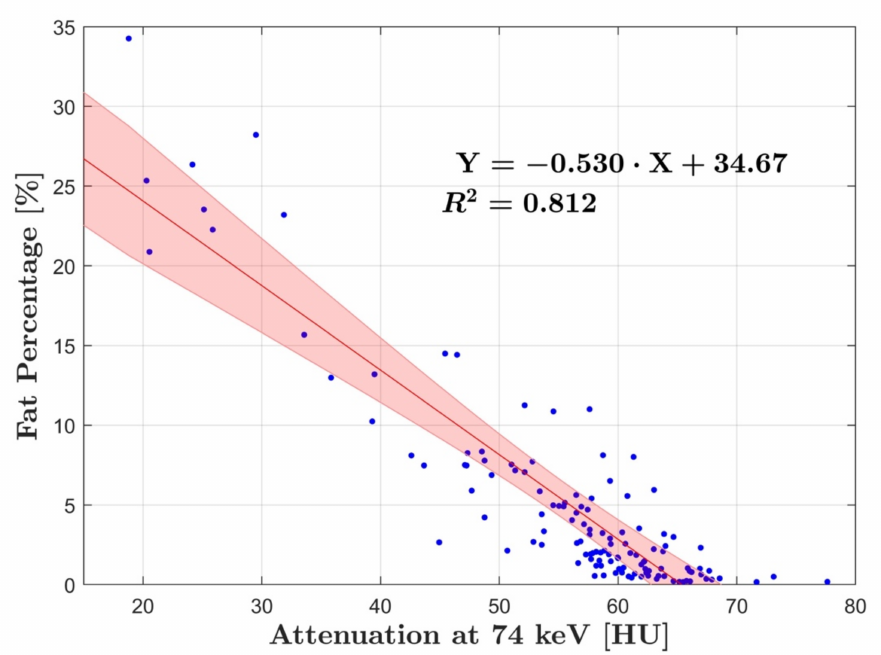
Figure 2. Linear regression analysis of group A showing the relationship between fat percentage and HU at 74 keV. The analysis showed strong correlation with an R 2 of 0.81. The blue dots represent the average fat and HU measurements for each patient, while the red line corresponds to the line of best fit, with the red shaded area showing the 95% CI.